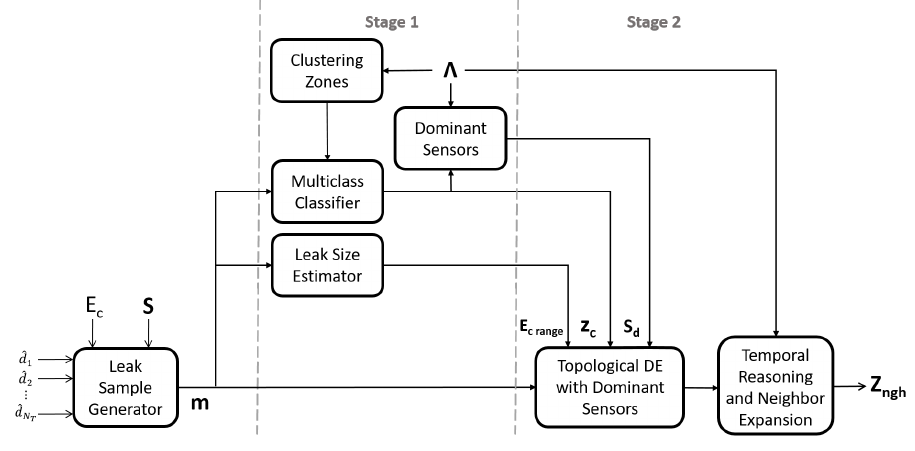
Figure 1. Leak Location